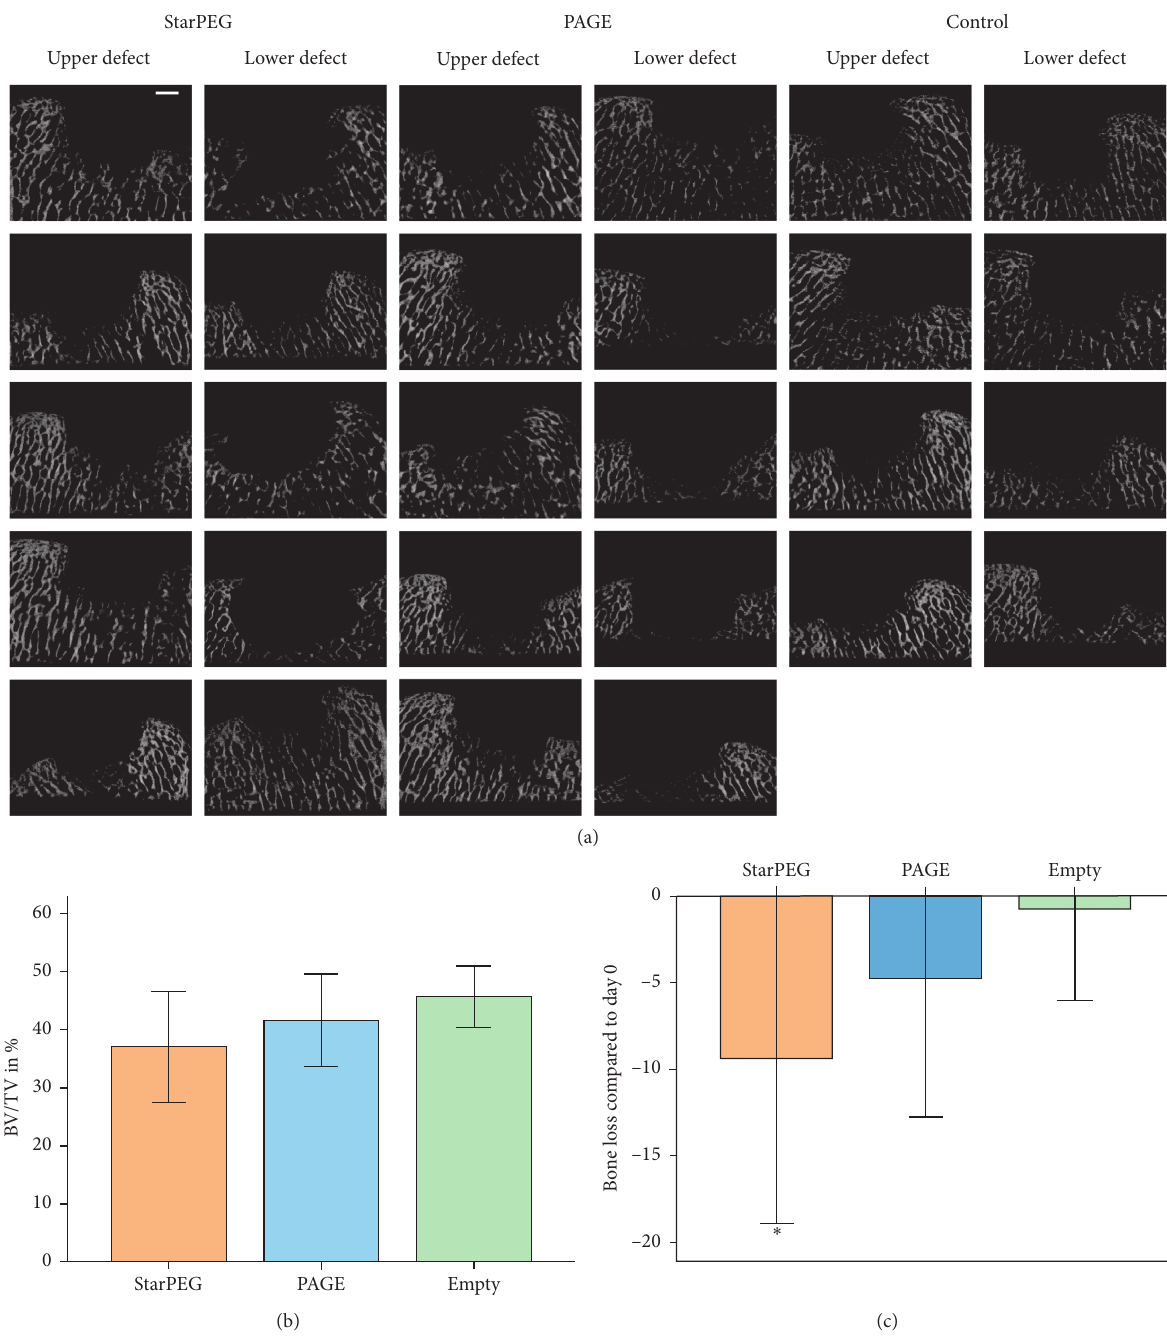
Figure 6: μ CTscans of osteochondral trochlea defects 12 weeks after implantation of different hydrogels. μ CT visualization revealing bone lysis in all groups, scale bar: 2mm (a). Bone volume/total volume was quantified in a volume of interest for each defect, and there was no statistical significance between the groups (b). To depict the loss of bone volume, BV/TV was compared to day 0 confirming more severe bone loss in defects treated with PCL-reinforced constructs compared to empty control defects. Mean percentage of bone loss ± SD per group compared to day 0 defects. ∗ : p ≤ 0 . 05 vs. empty control (ANOVA)